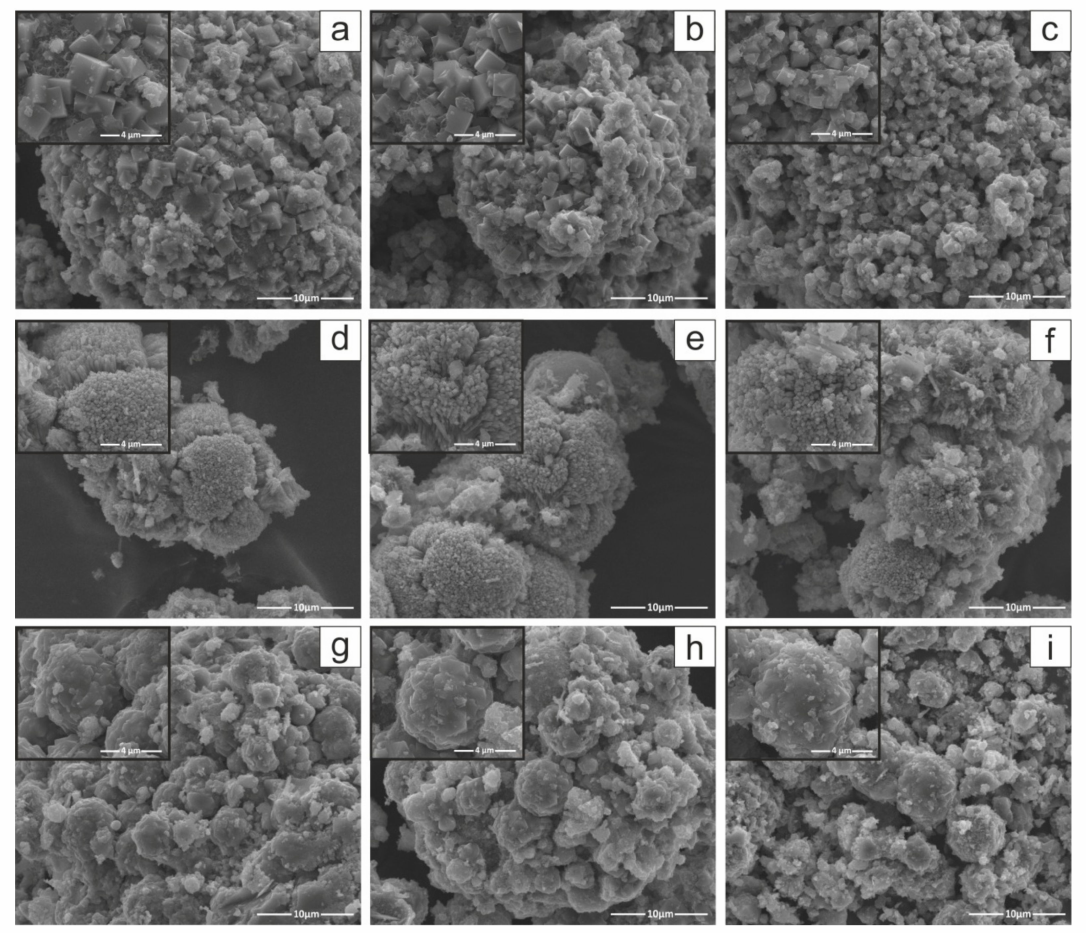
Figure 10. SEM images of zeolite products morphology, ( a – c ) Na-A, ( d – f ) Na-P1, ( g – i ) Na-X (magnifi- cation 8000, inset 30,000) for FA0, FA2, and FA3 as substrates,